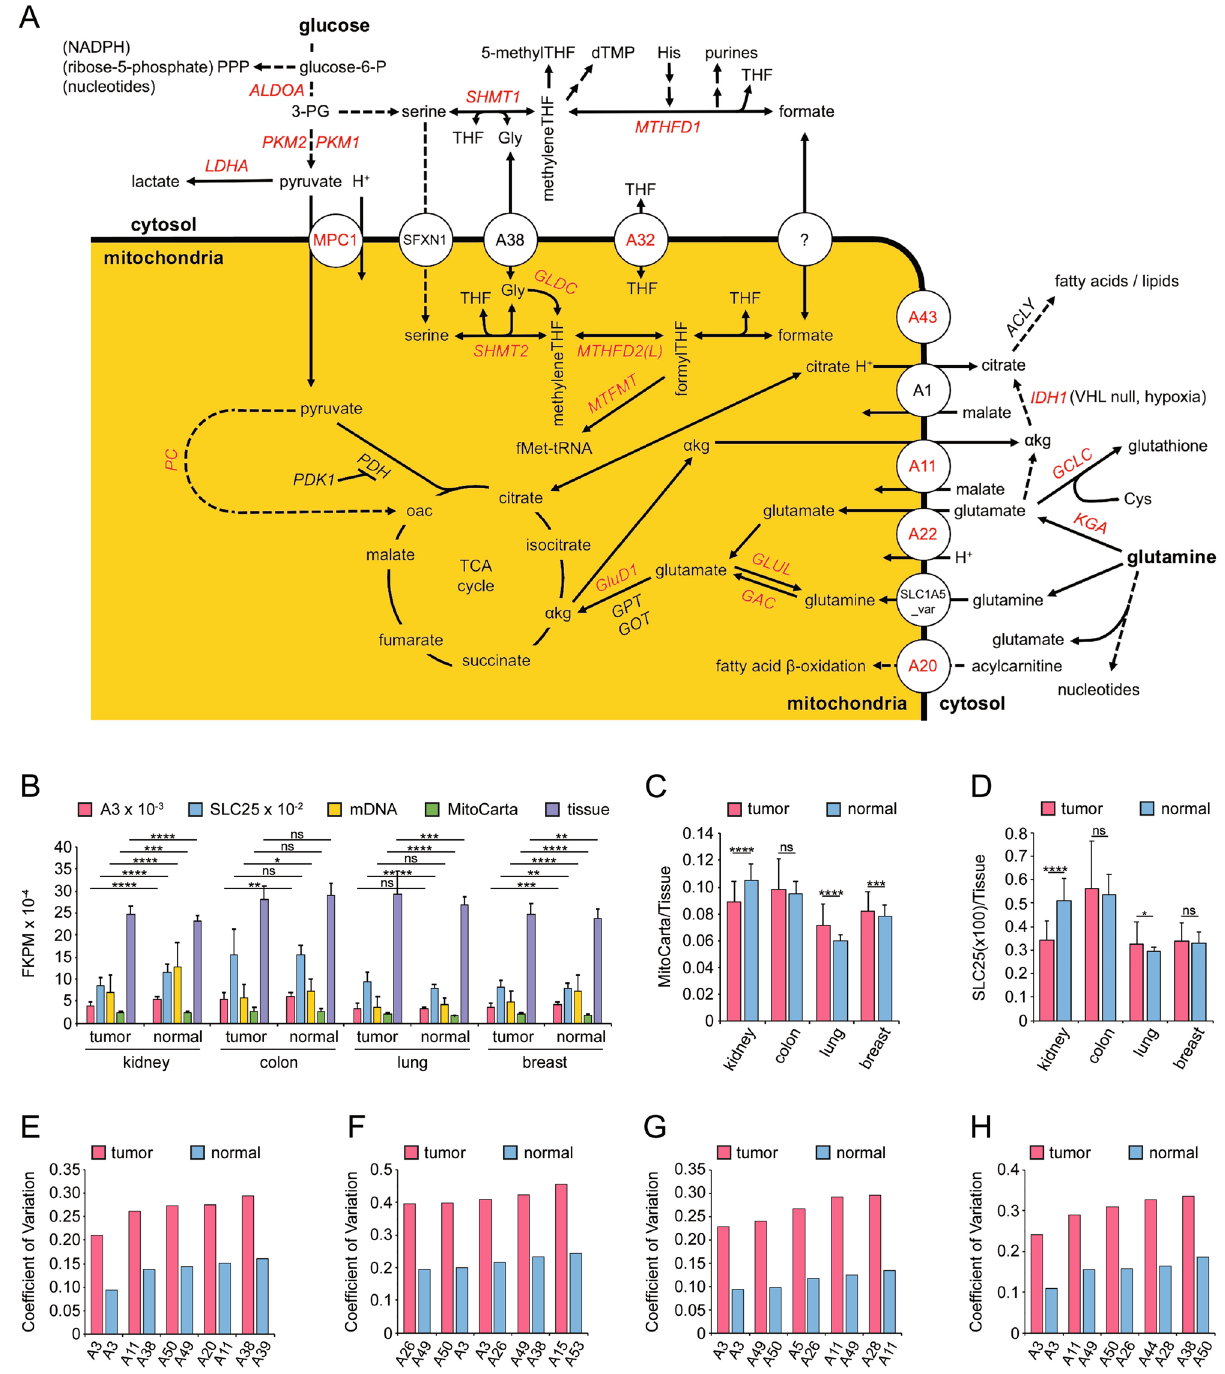
Figure 1. Mitochondrial SLC25 transporters. ( A ) Some mitochondrial transporters and their substrates. Transporters and enzymes assayed by RT-qPCR are shown in red (Supplementary Figs. S3–S5). ( B ) Gene expression of tumor and normal tissue. ‘A3’ denotes the SLC25A3 phosphate transport protein (PTP). ‘SLC25’ is the sum of FKPMs of all SLC25 genes. ‘mDNA’ is the sum of FPKMs of the 13 mitochondrial DNA protein coding genes. ‘Tissue’ refers to the sum of FKPMs of all protein coding genes on nuclear DNA. ( C ) Ratio of sum of FPKMs of MitoCarta over tissue genes in tumor and normal tissue from KIRC, COAD, LUAD and BRCA. ( D ) FPKM ratio of SLC25 over tissue genes from KIRC, COAD, LUAD, and BRCA and normal tissue. Error bar standard deviation. Only transporters with smallest coefficient of variation (standard deviation/mean) of transporter FPKM/sum of MitoCarta gene FPKMs from tumor and normal tissue for kidney [( E ) KIRC)], colon [( F ) COAD)], lung [( G ) LUAD], and breast [( H ) BRCA] are shown. Those of all SLC25 transporters are shown in Supplementary Fig.